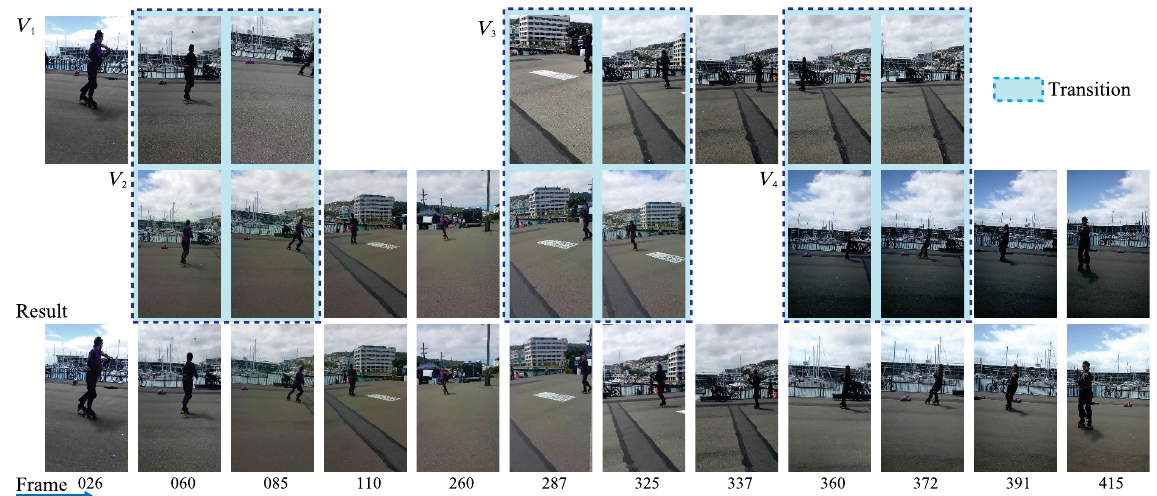
Fig. 8 Inputs and outputs of our full algorithm. Blue rectangles indicate when the transition occurs.